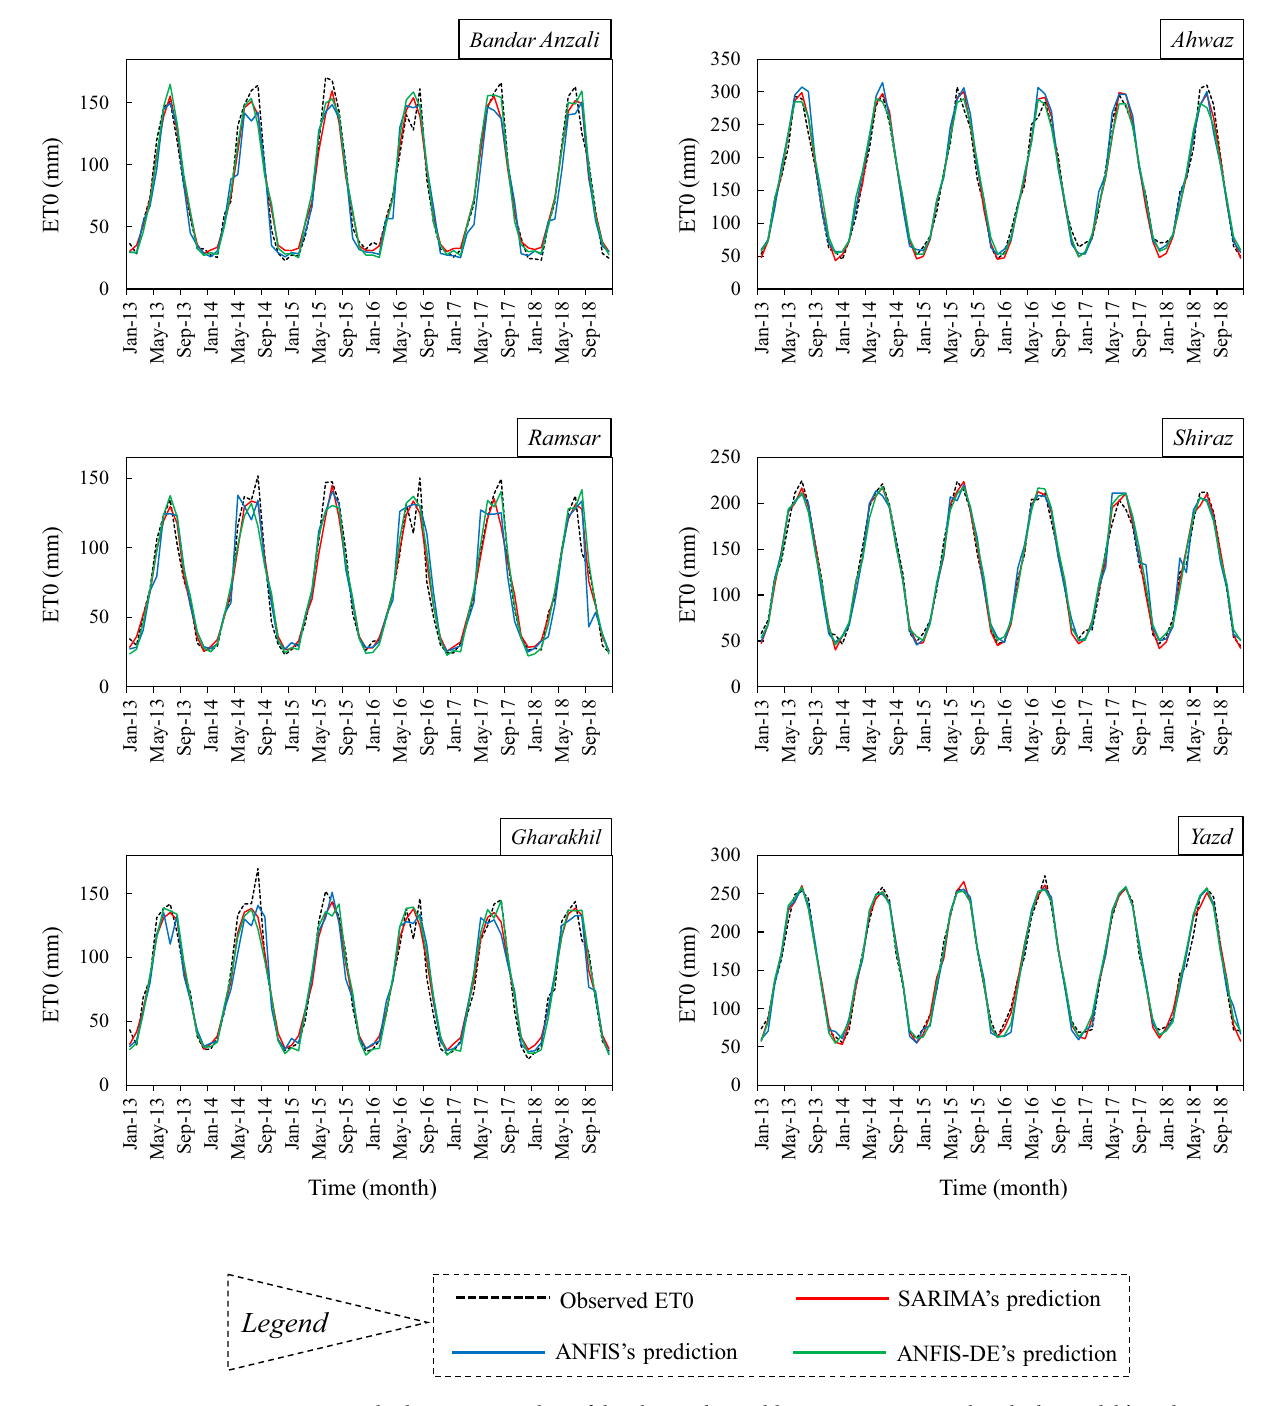
Figure 9. Multiple time series plots of the observed monthly evapotranspiration beside the models’